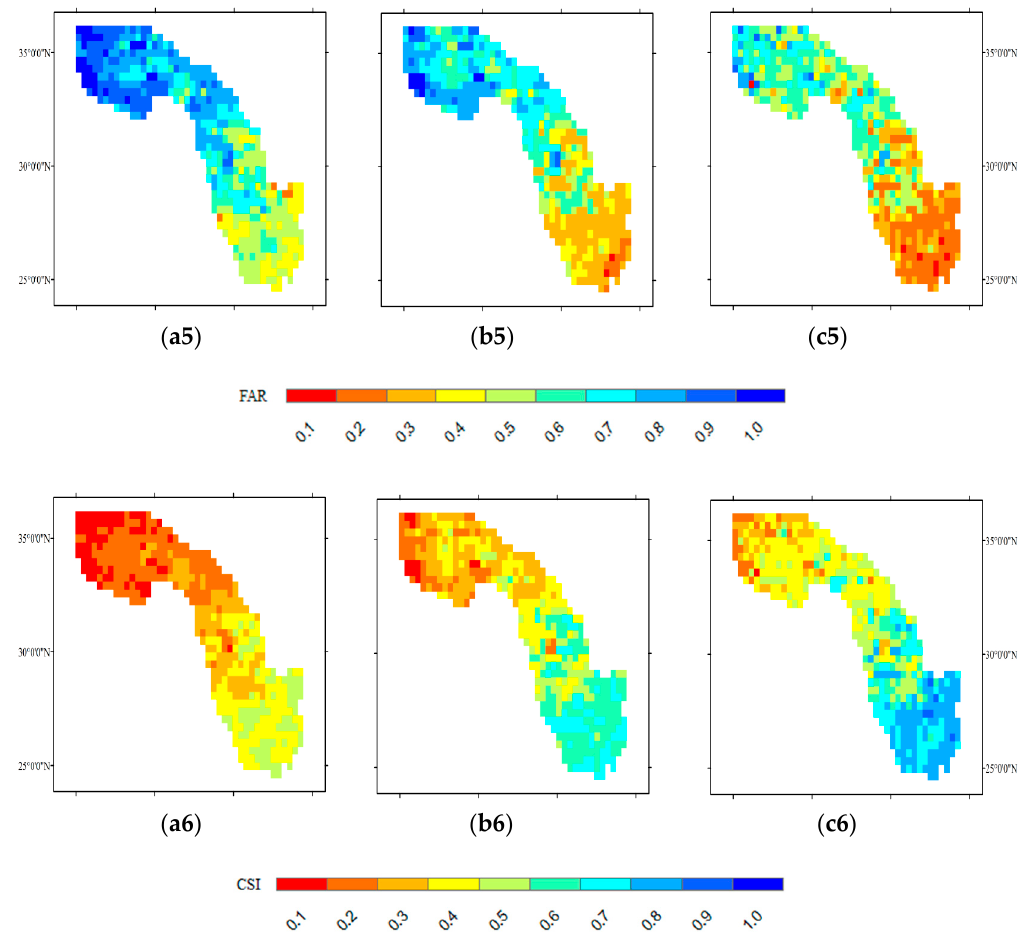
Figure 6. Spatial distribution of precipitation error markers in the Jinsha River Basin: ( a1 , b1 , c1 ) R; ( a2 , b2 , c2 ) RMSE; ( a3 , b3 , c3 ) ME; ( a4 , b4 , c4 ) POD; ( a5 , b5 , c5 ) FAR; ( a6 , b6 , c6 ) CSI.